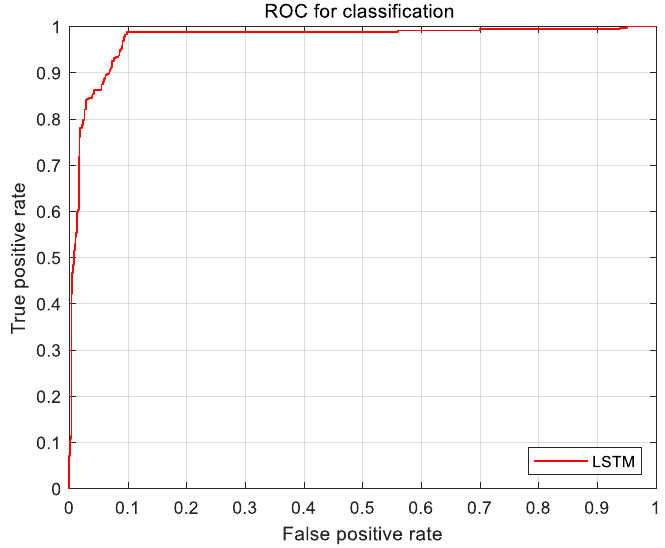
Figure 9. ROC curves for the case of the current lane having a car in front of the vehicle.